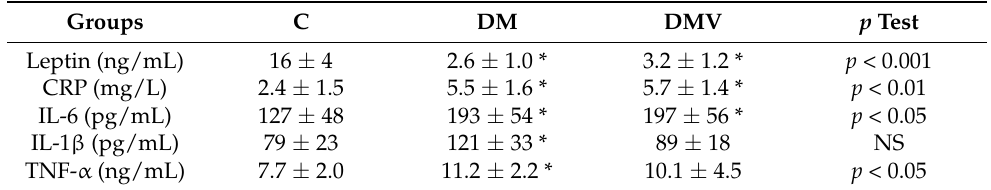
Table 2. Serum level of leptin, C-reactive protein (CRP), interleukin-6 (IL-6), interleukin-1 β (IL-1 β ), and tumor necrosis factor alpha (TNF- α ) on day 35.